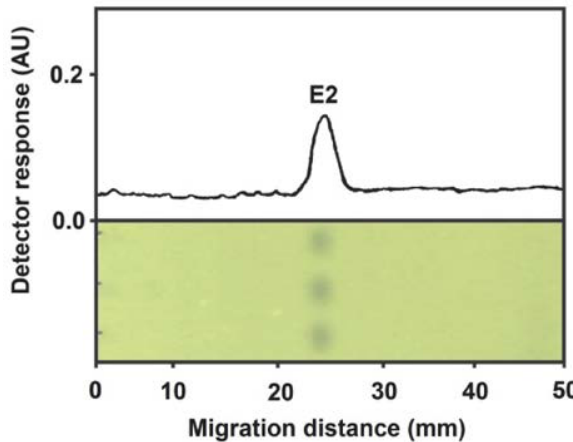
Figure 1. TLC chromatogram and densitogram of estradiol (E2) standard (0.25 mg mL –1 ; n = 3); stationary phase: silica gel, develop- ing solvent: toluene-ethanol (9:1; v/v ), detection reagent: 10% phos- phomolybdic acid in methanol, λ = 430 nm, sample volume: 0.3